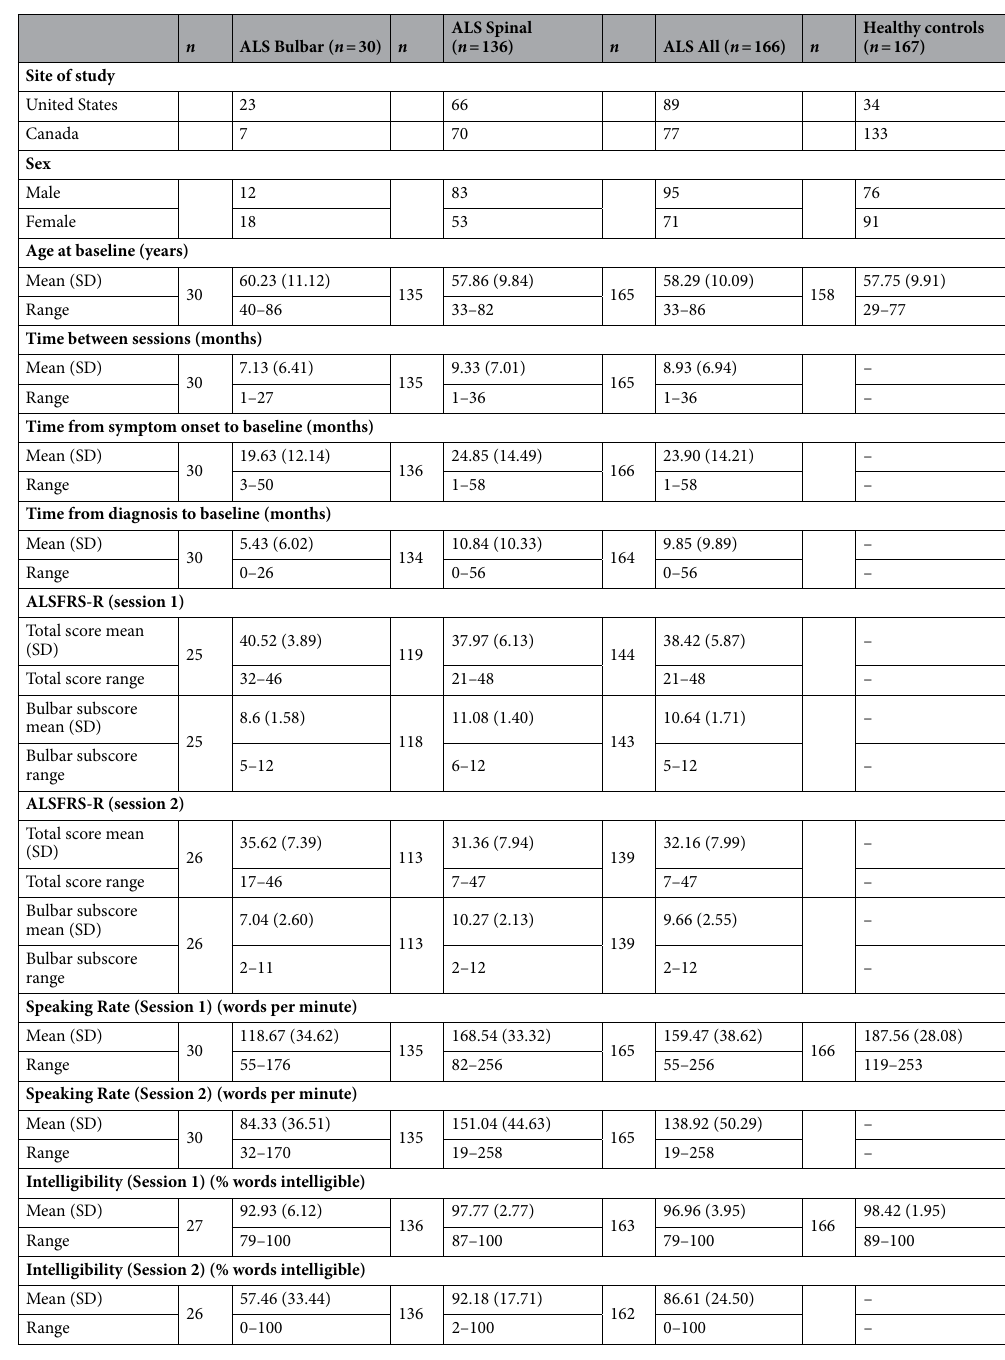
Table 1. Demographic and clinical features of participants. Not all subjects had a data point for every statistic. Total sample sizes are reported in parentheses under each group name. The number of subjects, mean, SD, and range values are provided for each statistic. ALS amyotrophic lateral sclerosis, ALS-FRS-R Revised Amyotrophic Lateral Sclerosis Functional Rating Scale, SD standard